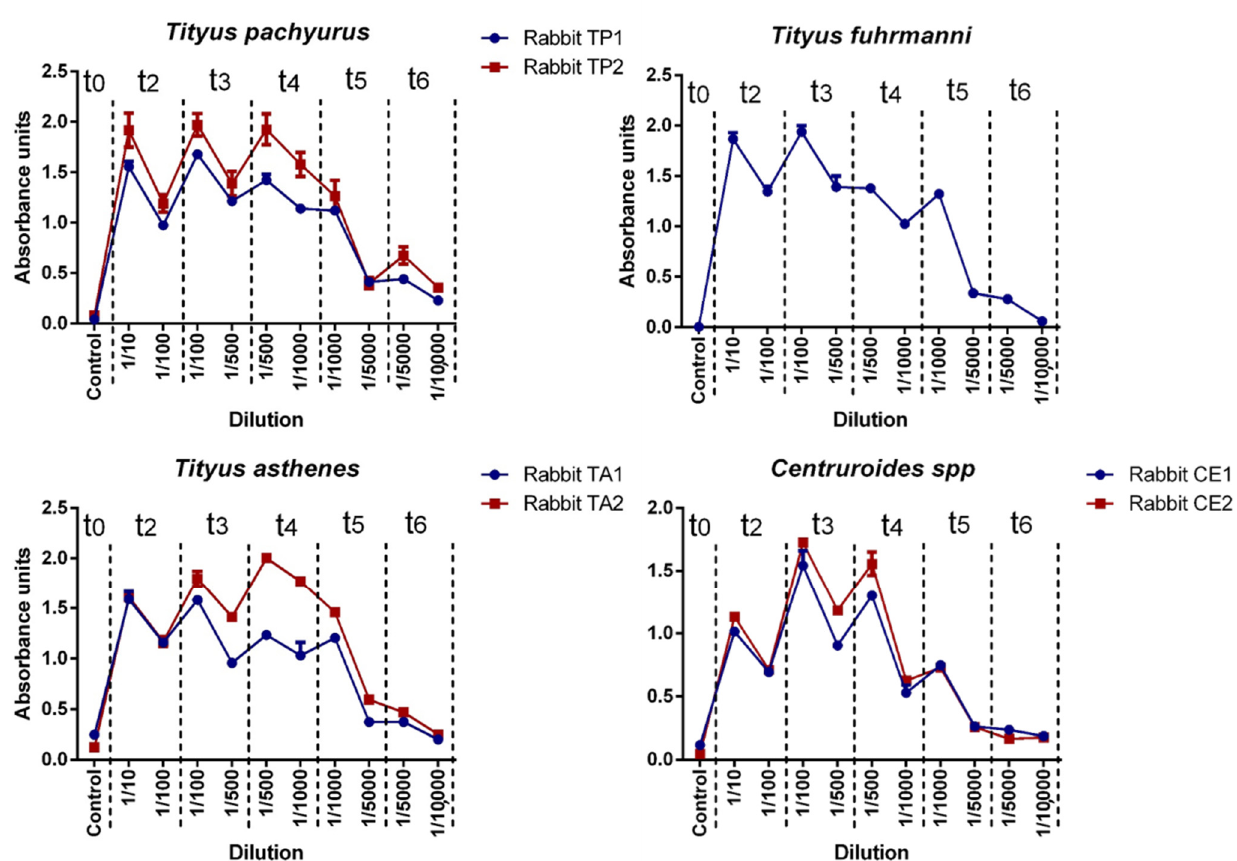
Figure 3. IgG quantification. Antibody production by antigen batch group after each immunization period. Only one rabbit was used on Tityus fuhrmanni venom. Pharmaceuticals 2022 , 15 , x FOR PEER REVIEW